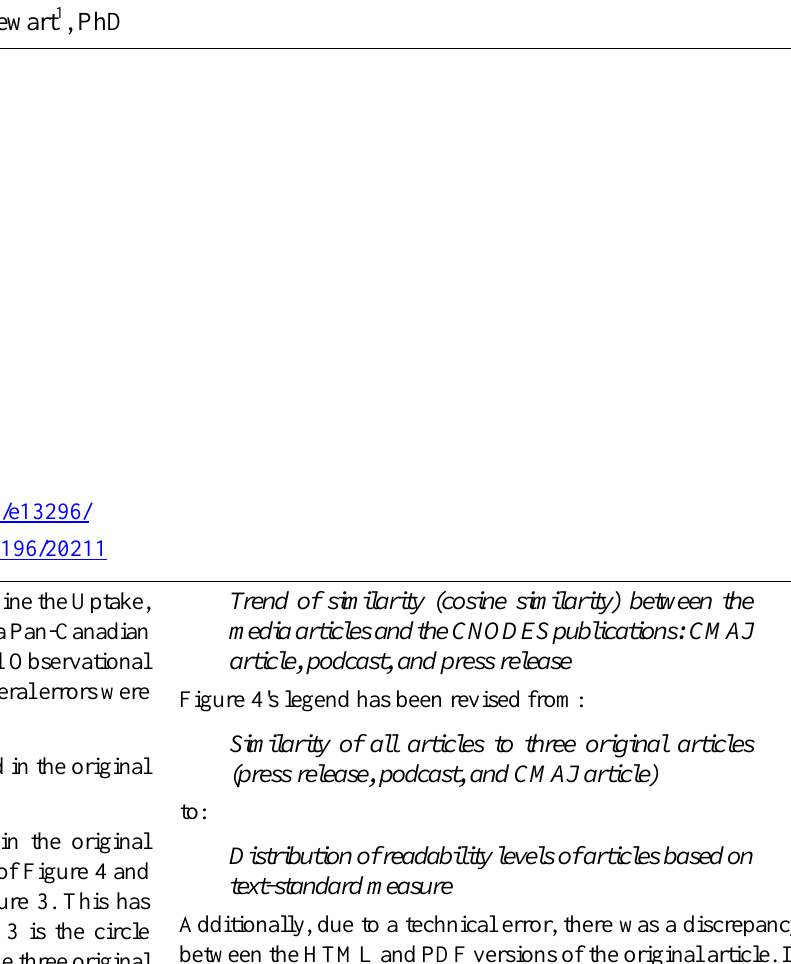
Figure 3's legend has been revised from: